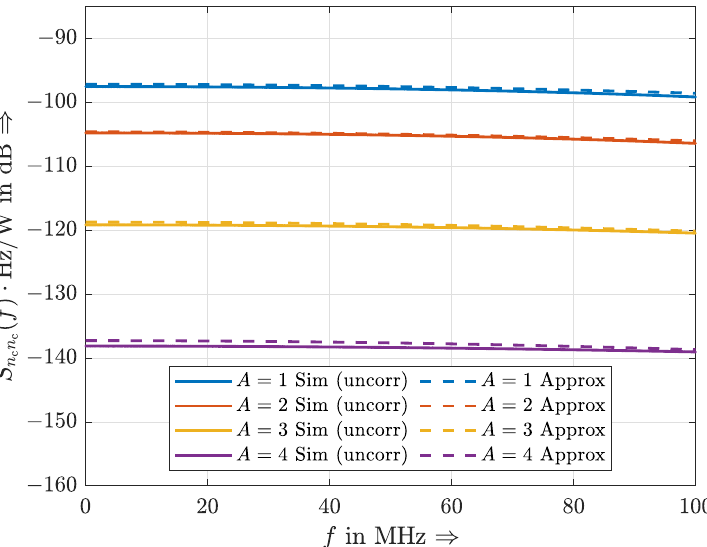
Figure 12. Approximated analytical and simulated power spectral density of the uncorrelated part of the clipping distortion for σ 2 x = 1, B = 200 MHz and different clipping levels A